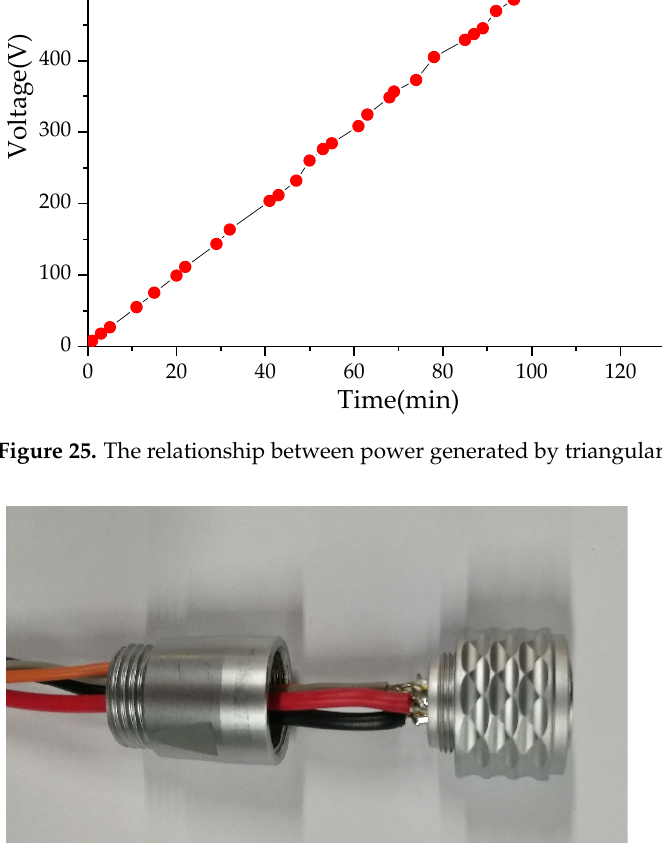
Figure 27. The self-powered performance test of sensor.